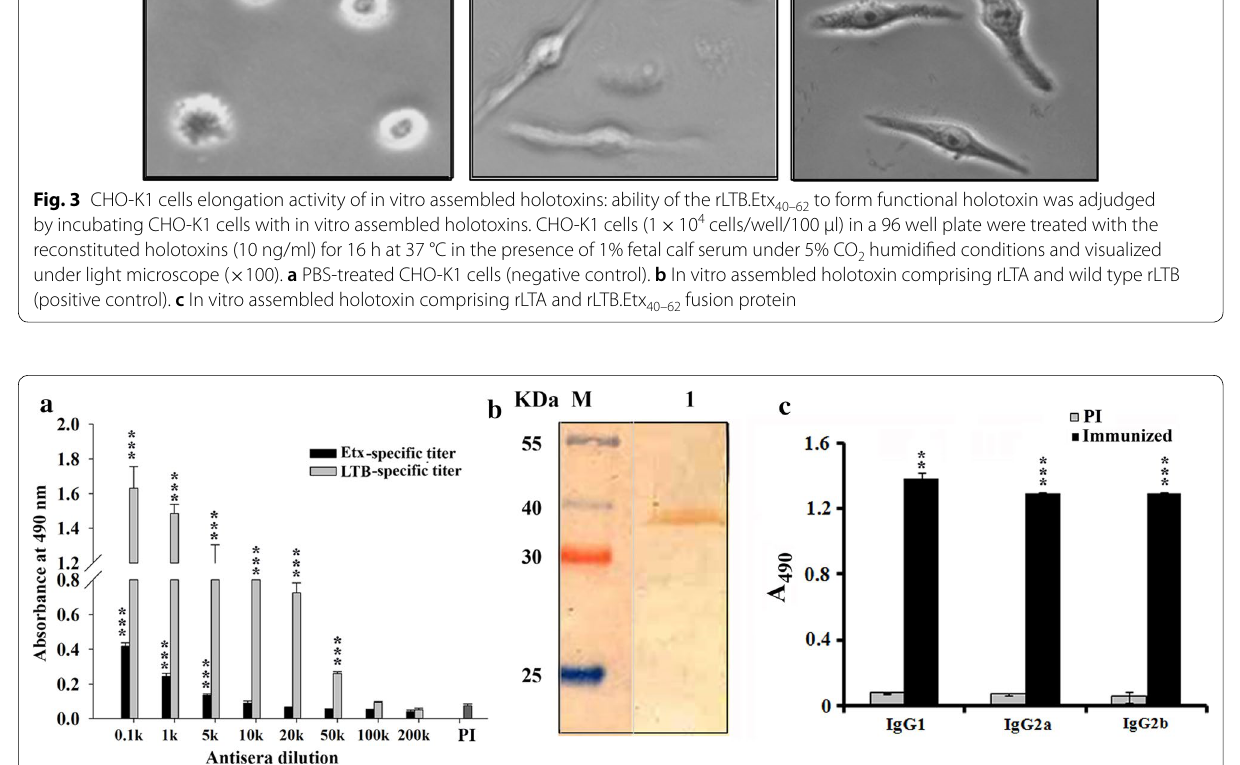
generated when the LTB (Additional file 1: Figure S1A, p 0.05 to p 0.001 at different dilutions with respect to ≤ ≤ preimmune serum) and fusion protein (Additional file 1: Figure S1B, p 0.005 to p 0.001 at different dilutions ≤ ≤ with respect to preimmune serum) were administered by themselves, confirming the self-adjuvanting activ- ity of the LTB. Immunization of the LTB and the rLTB. Etx 40–62 with alum as adjuvant (B and D, respectively) augmented the immune response as significantly higher absorbance in ELISA was obtained when compared to the absorbance obtained with the antisera generated against the LTB (Additional file 1: Figure S1C, p 0.01 ≤